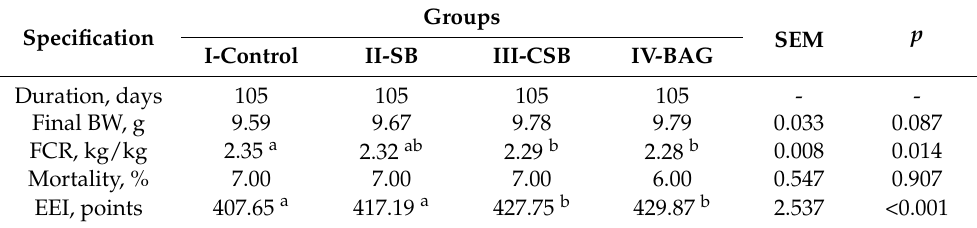
Table 2. Effect of the dietary treatments on the performance of turkeys.